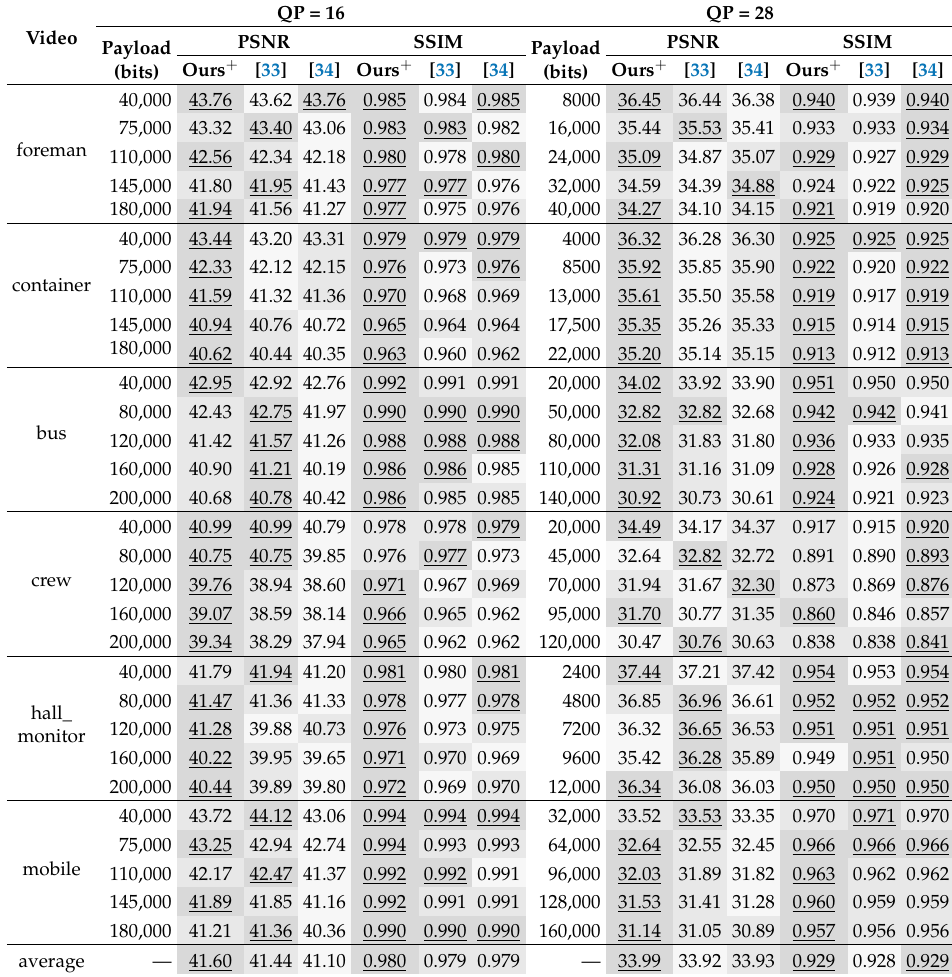
Table 4. PSNR and SSIM for different schemes using the ( 0,0 ) coefficient pairs, where payload is the number of bits embedded into each GOP.